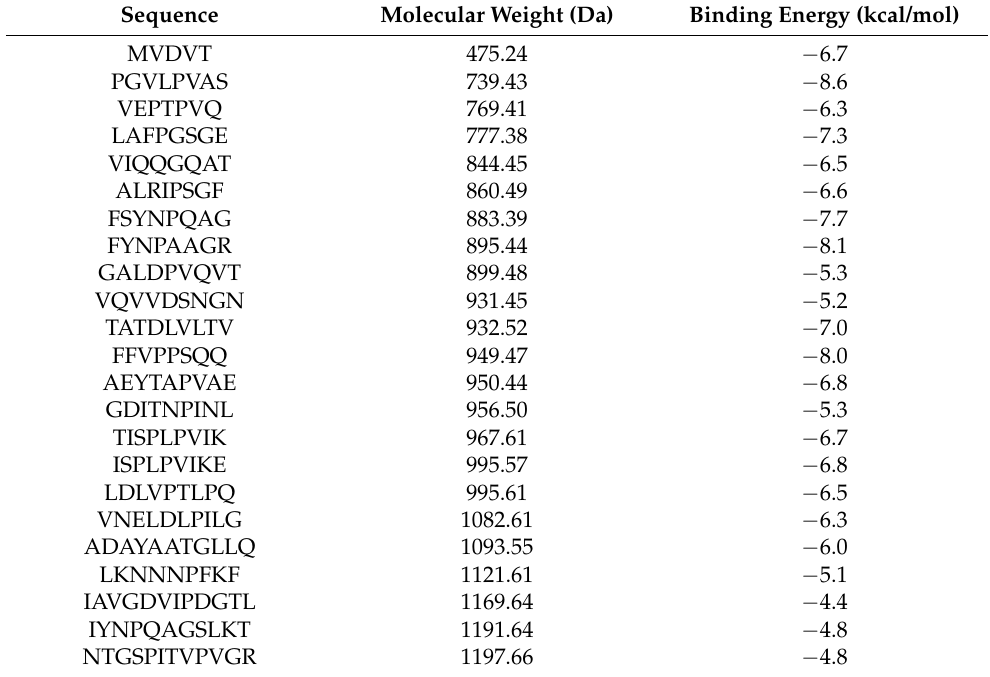
Table 1. Basic information on the 23 peptides screened from